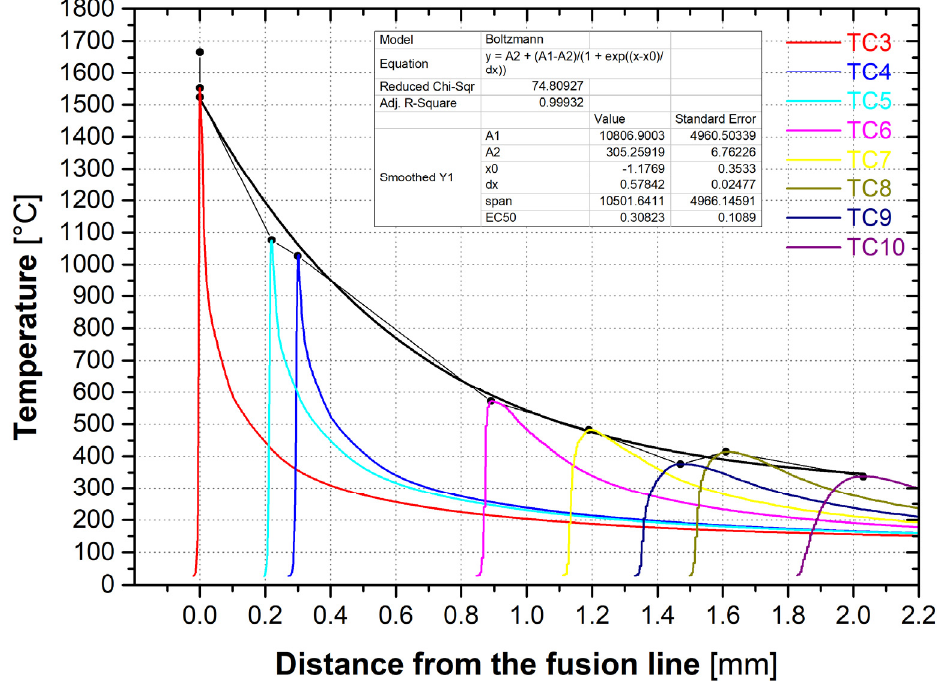
Figure 12. Mathematical description defining the temperature distribution in HAZ for weld with a heat input value 8 kJ·cm − 1 .